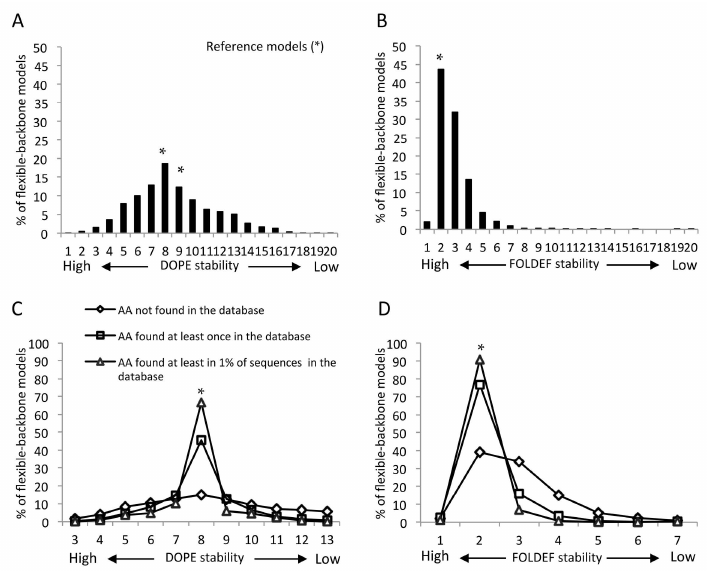
Figure 1. Distribution of capsid protein mutant stabilities based on flexible-backbone models of the mature capsid (CA) hexamer. The stability bin reflects the structural stability from higher ( left ) to Revise the asterisks into Palatino linotype. lower ( right ) levels. * indicates the bin in which reference structures were found. All mutations predicted by Discrete optimized protein energy (DOPE) ( A , C ) and FoldX energy function (FOLDEF) ( B , D ) were classified into three groups based on their frequency in the HIV sequence database. Only results from five higher, five lower and the reference model bins are shown, as together they accounted for more than 98% of all